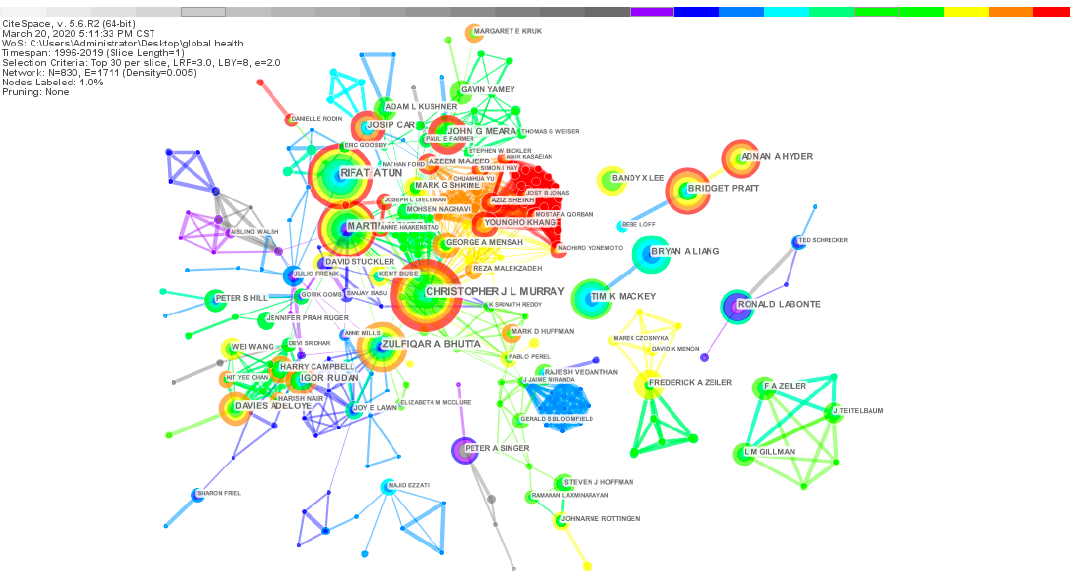
Figure 4. Knowledge map of co-author collaboration network.